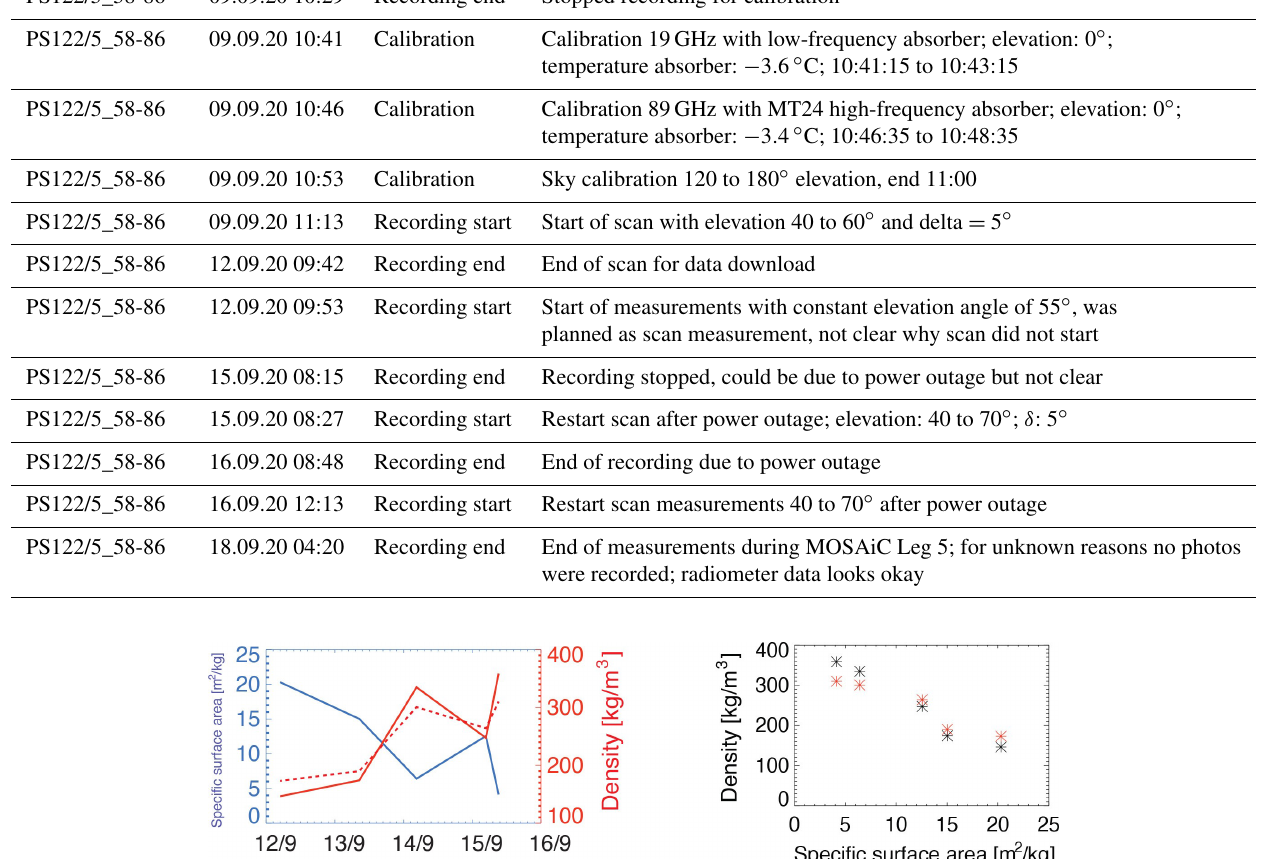
Figure A1. Depth-averaged micro-CT density and specific surface area (SSA) during the rain-on-snow event and comparison with density cutter. Image on left shows the average density (red line) and SSA (blue line) from micro-CT and density cutter (dotted line). Image on the right shows the SSA vs. density from micro-CT (black) and the density cutter